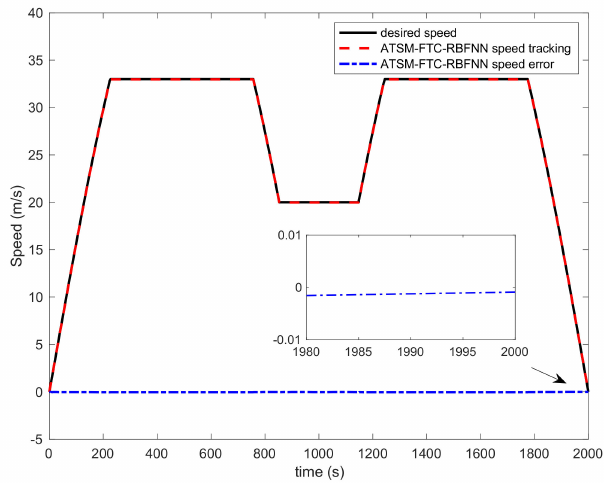
Figure 5. Speed tracking performance of ATSM-FTC-RBFNN.